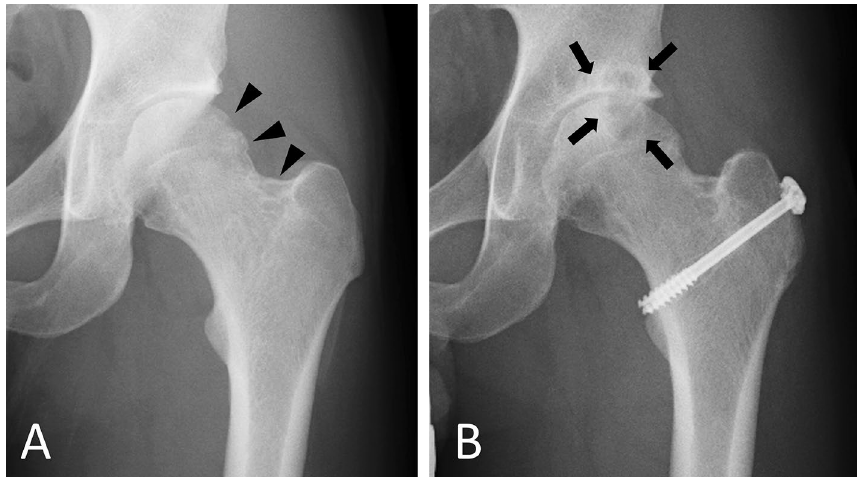
Figure 3. Osteochondral lesion in hip joint. ( A ) A 27-year-old men with hip TSGCT. An anterior–posterior radiograph showed osteolytic lesion in left femoral head and neck region (arrowheads), however there is no obvious osteoarthritic change at initial examination. ( B ) Three years after tumor resection. After surgery for TSGCT, osteoarthritic change occurred (arrows).